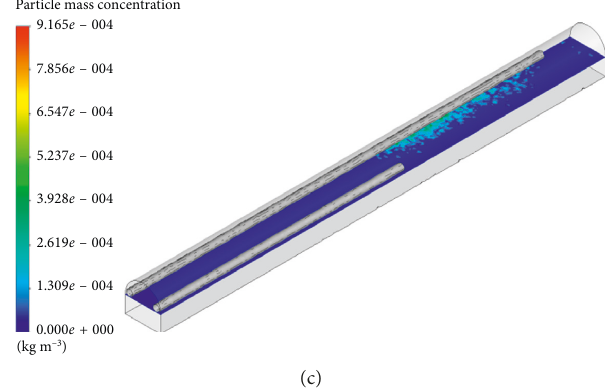
Figure 10: Influence of H on the mass concentration of dust. (a) 1.4m, (b) 1.6m, and (c)